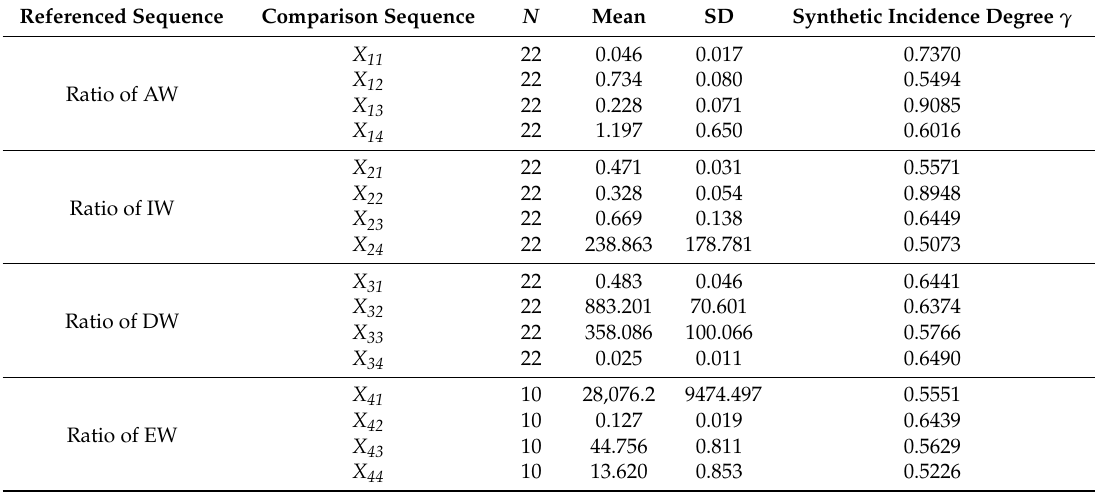
Table 1. Grey incidence analysis between the relative water consumption ratios and driving